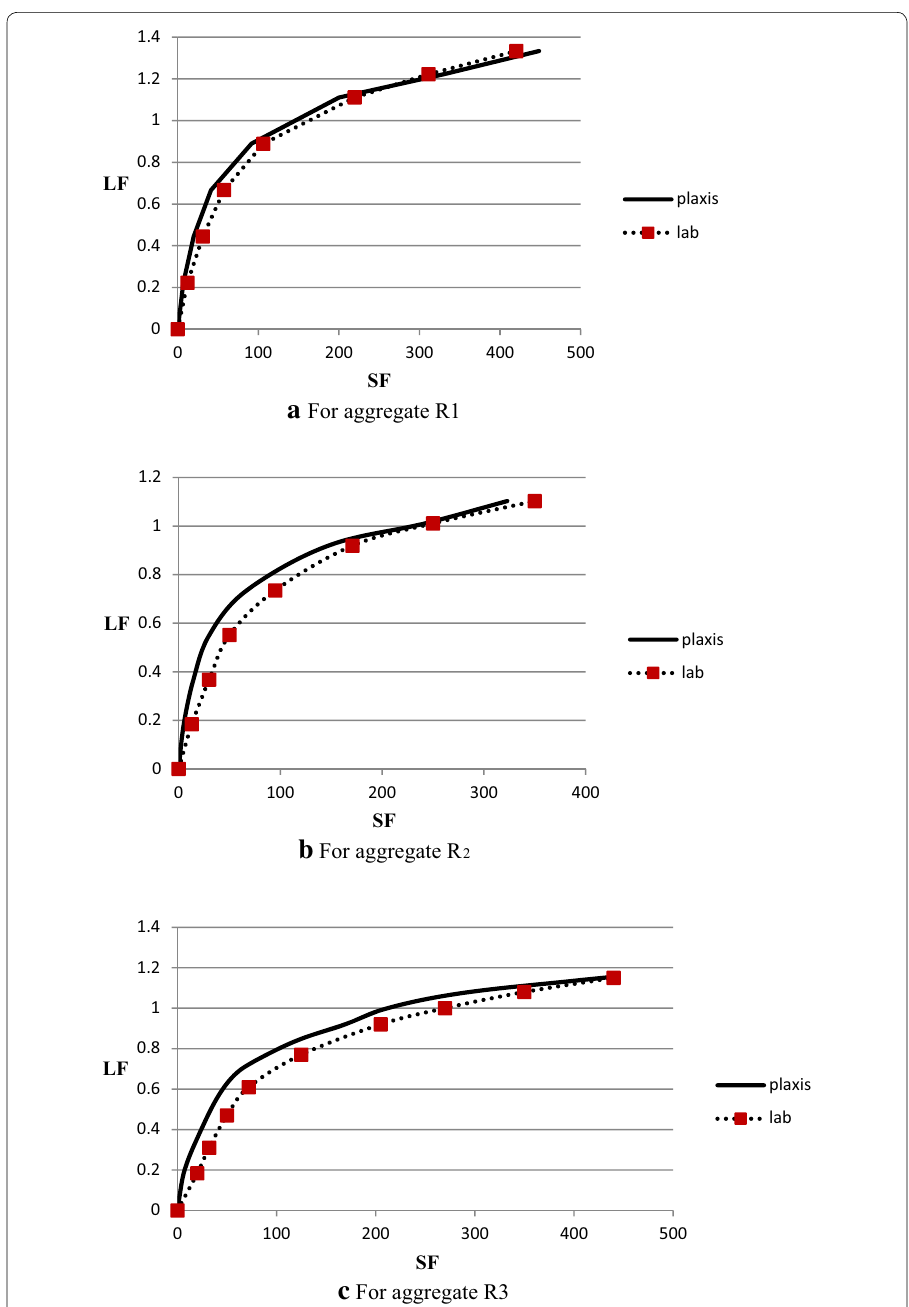
Fig. 12 Comparison of numerical and experimental results for half-length encased stone column in sand